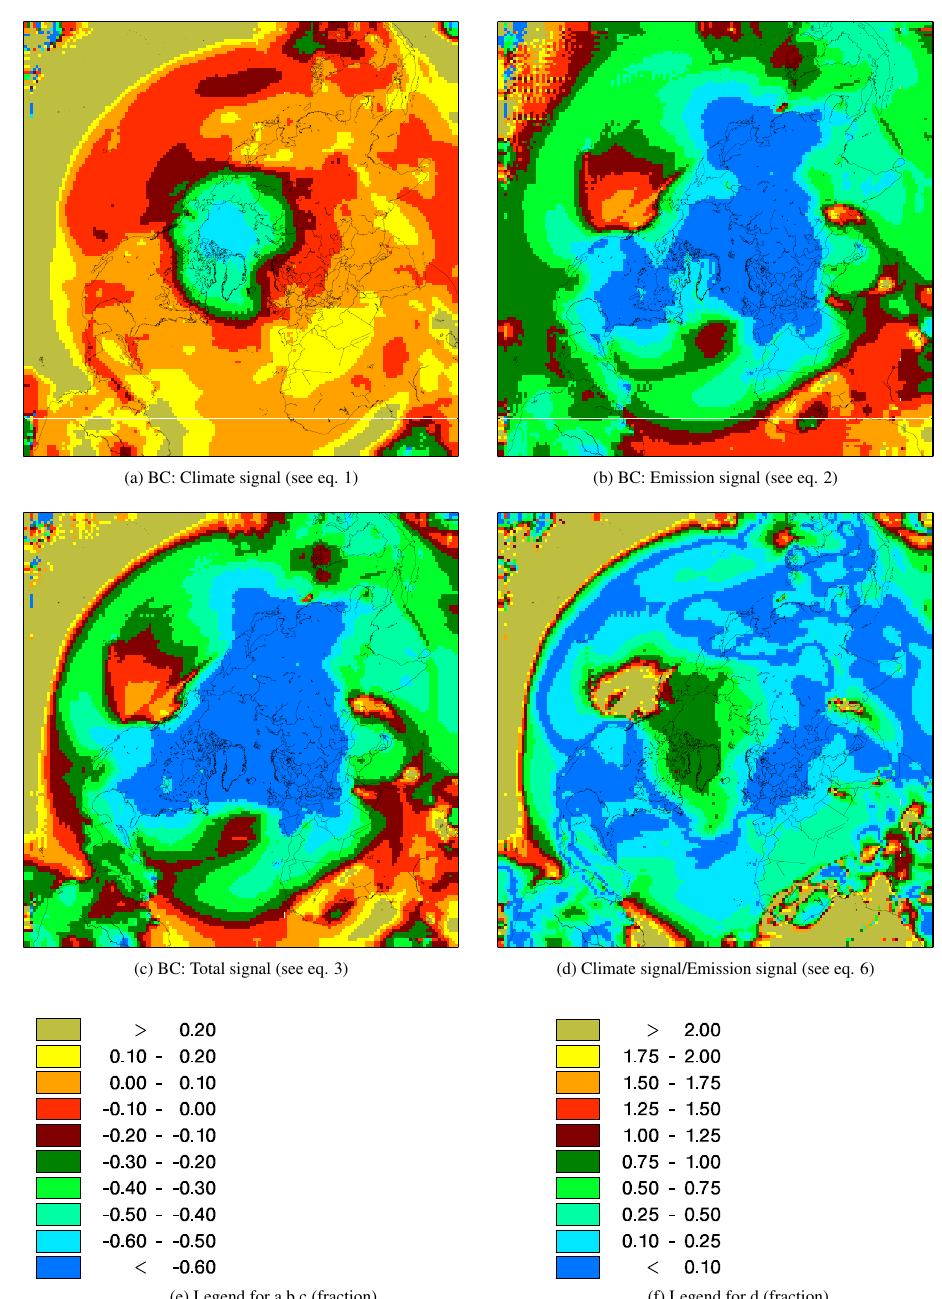
Fig. 5. Black carbon (BC): as Fig. 4, but for black Fig. 5: Black Carbon (BC): As Fig. 4 but for black carbon